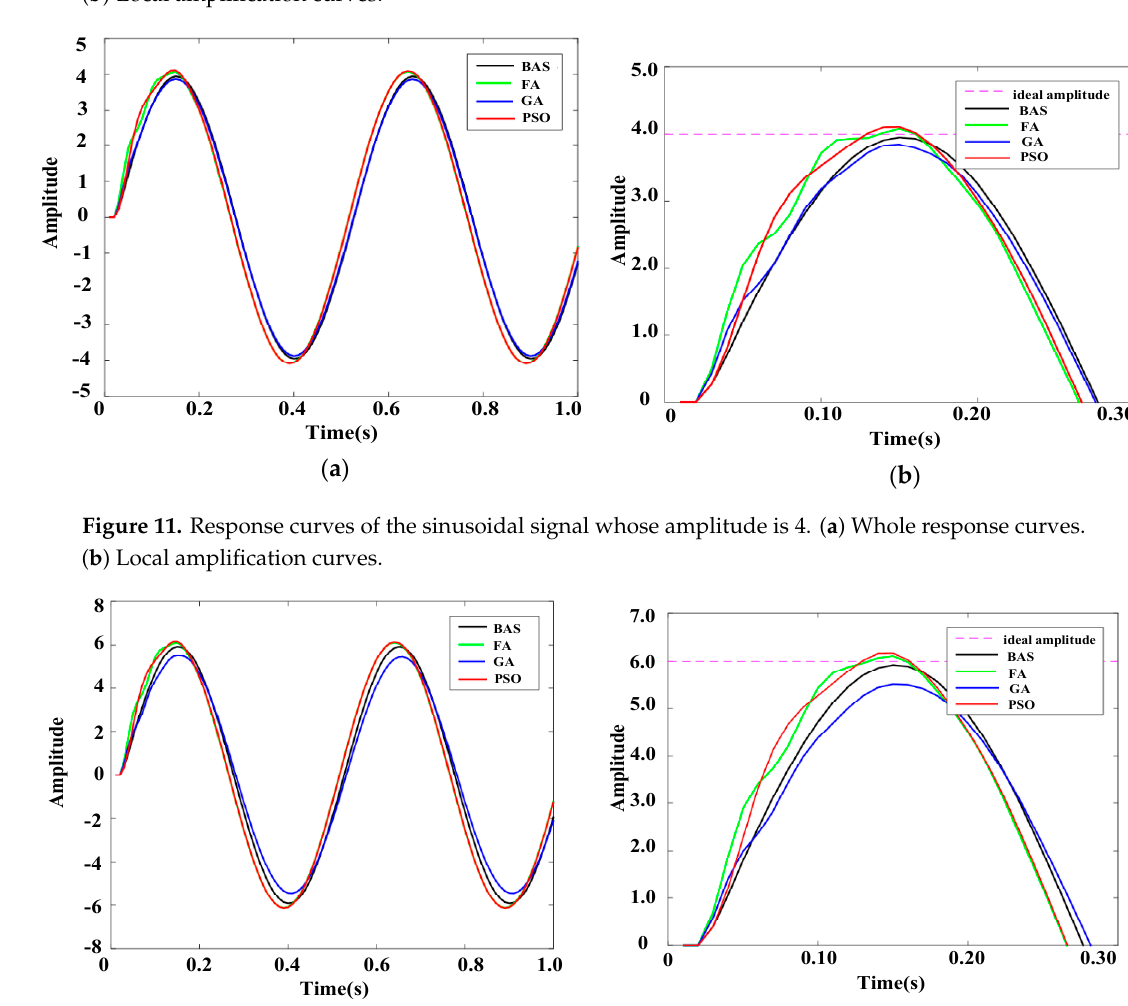
Figure 10. Response curves of the sinusoidal signal whose amplitude is 2. ( a ) Whole response curves. ( b ) Local amplification curves.